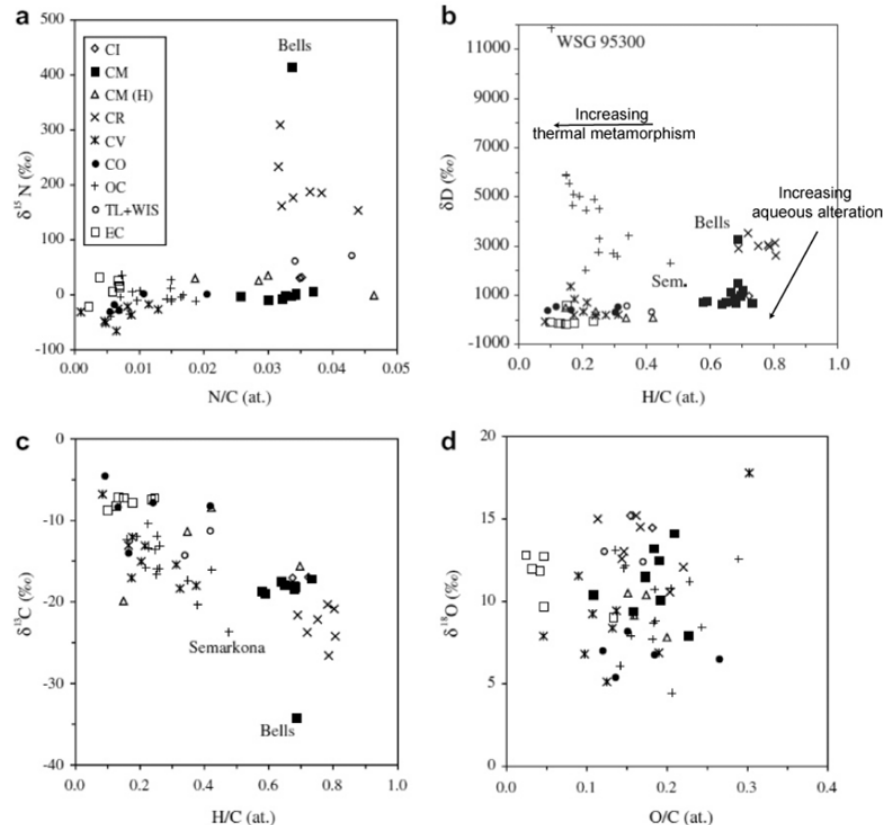
Figure 7. Isotopic compositions vs the relevant elemental ratio in the IOM of chondrites of various classes, from [17, 93]. Correlations may be observed for some groups for H isotopes (b) (like for instance an increase in (cid:4) D with a decrease in H/C in the case of ordinary chondrites), or C isotopes (c) (see the increase of (cid:4) 13 C with decreasing H/C). For N isotopes (a), no clear trend is observed. O isotopes (d) do not show any pattern, and the values are in the range of solar system